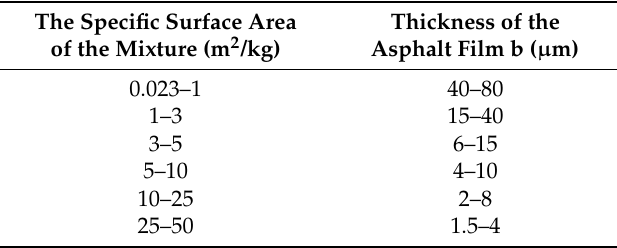
Table 5. Thickness of the asphalt film depending on the specific surface area.